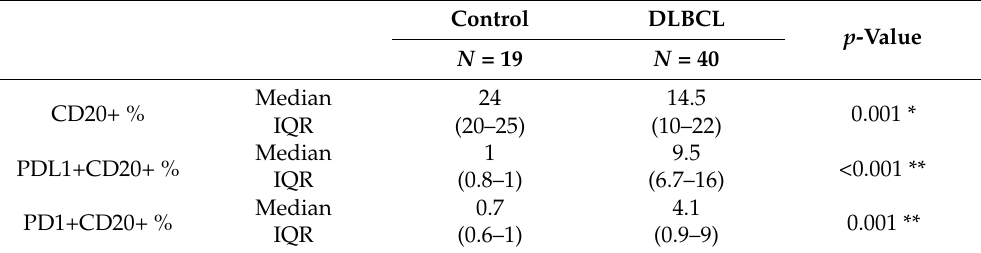
Table 2. Comparison between normal controls and patients regarding CD20+ %, PD-L1+CD20+ %, and PD-1+CD20+